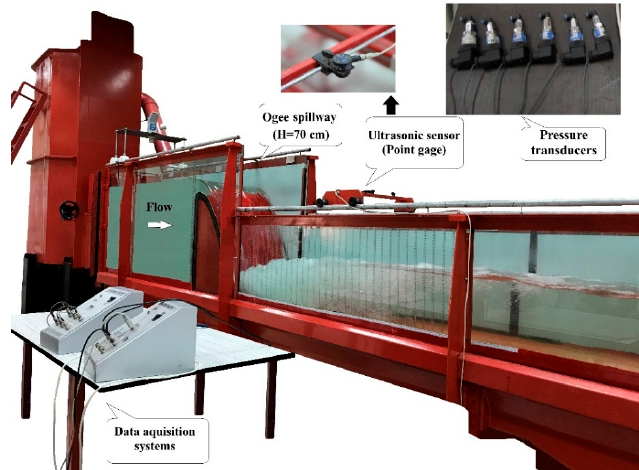
Figure 1. Laboratory flume and the experimental